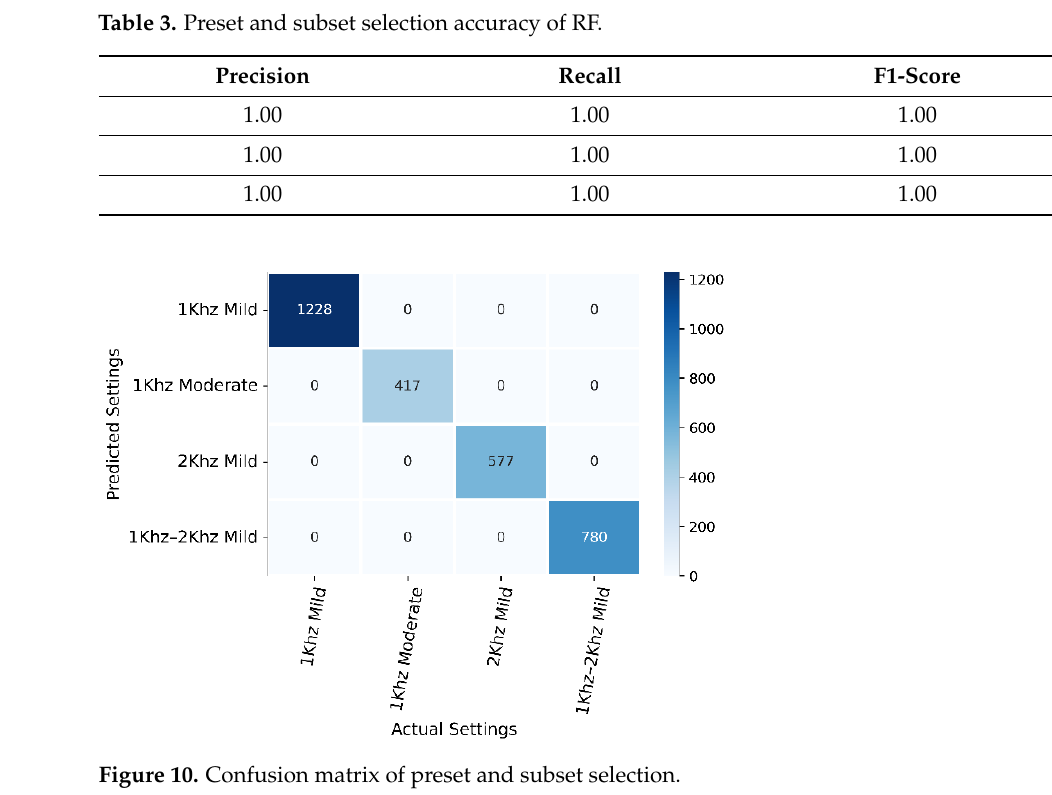
Figure 9. Confusion matrix of scene classification with 12 MFCC features.